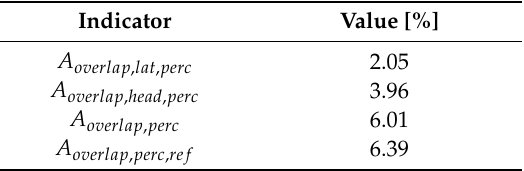
Table 3. Overlapping